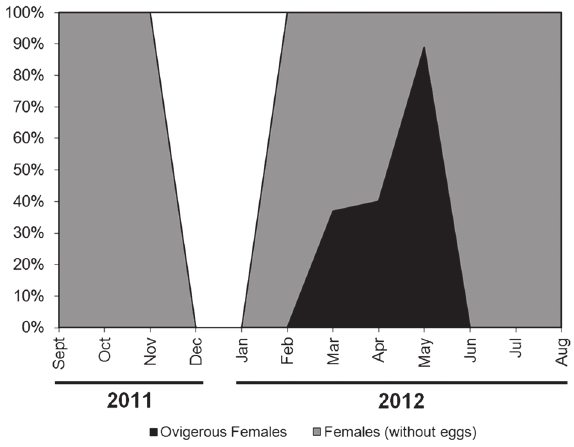
Figure 3. Ucides cordatus (Linnaeus, 1763). The relative frequencies of females (ovigerous and non-ovigerous) captured monthly in the mangroves of the Joanes River, Lauro de Freitas Municipality (Bahia State, Brazil) between September 2011 and August 2012. In December and January, the crab-catchers were not available.